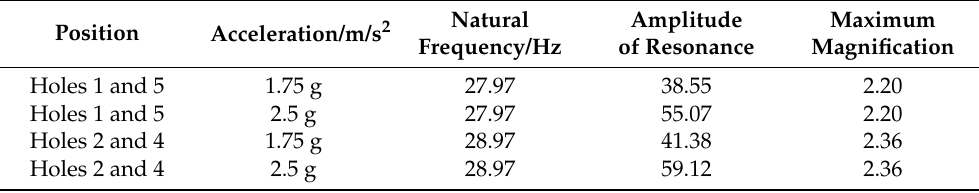
Table 3. Frequency-response results.